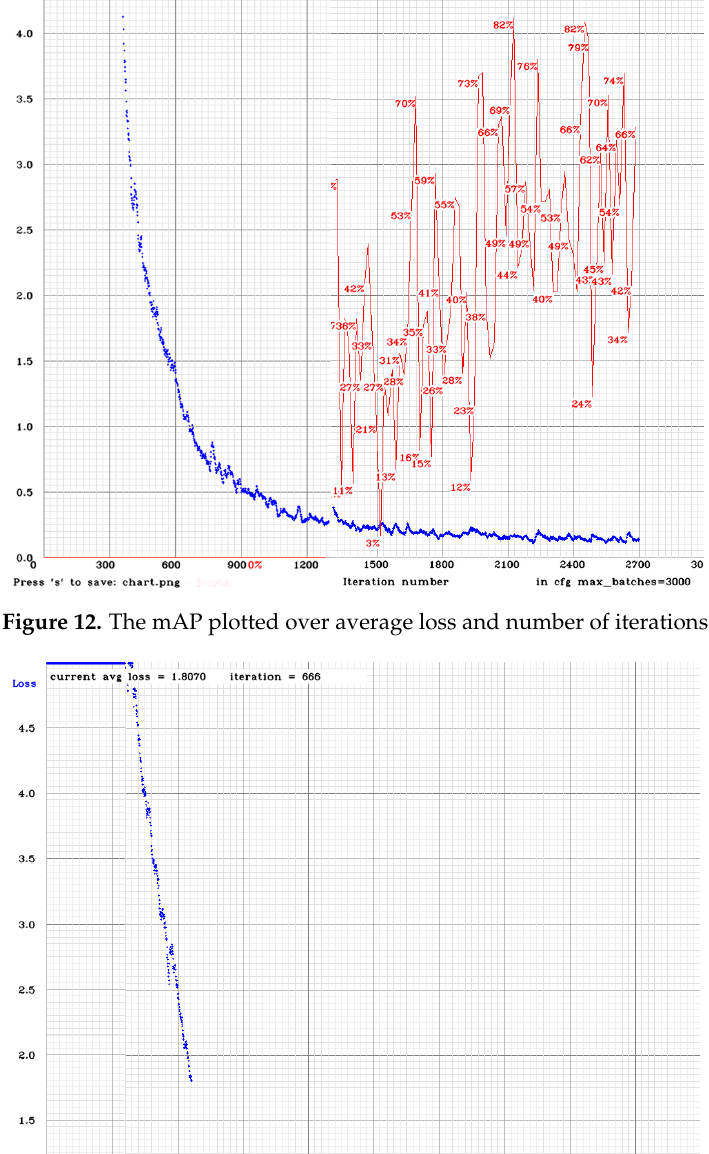
Figure 12. The mAP plotted over average loss and number of iterations.